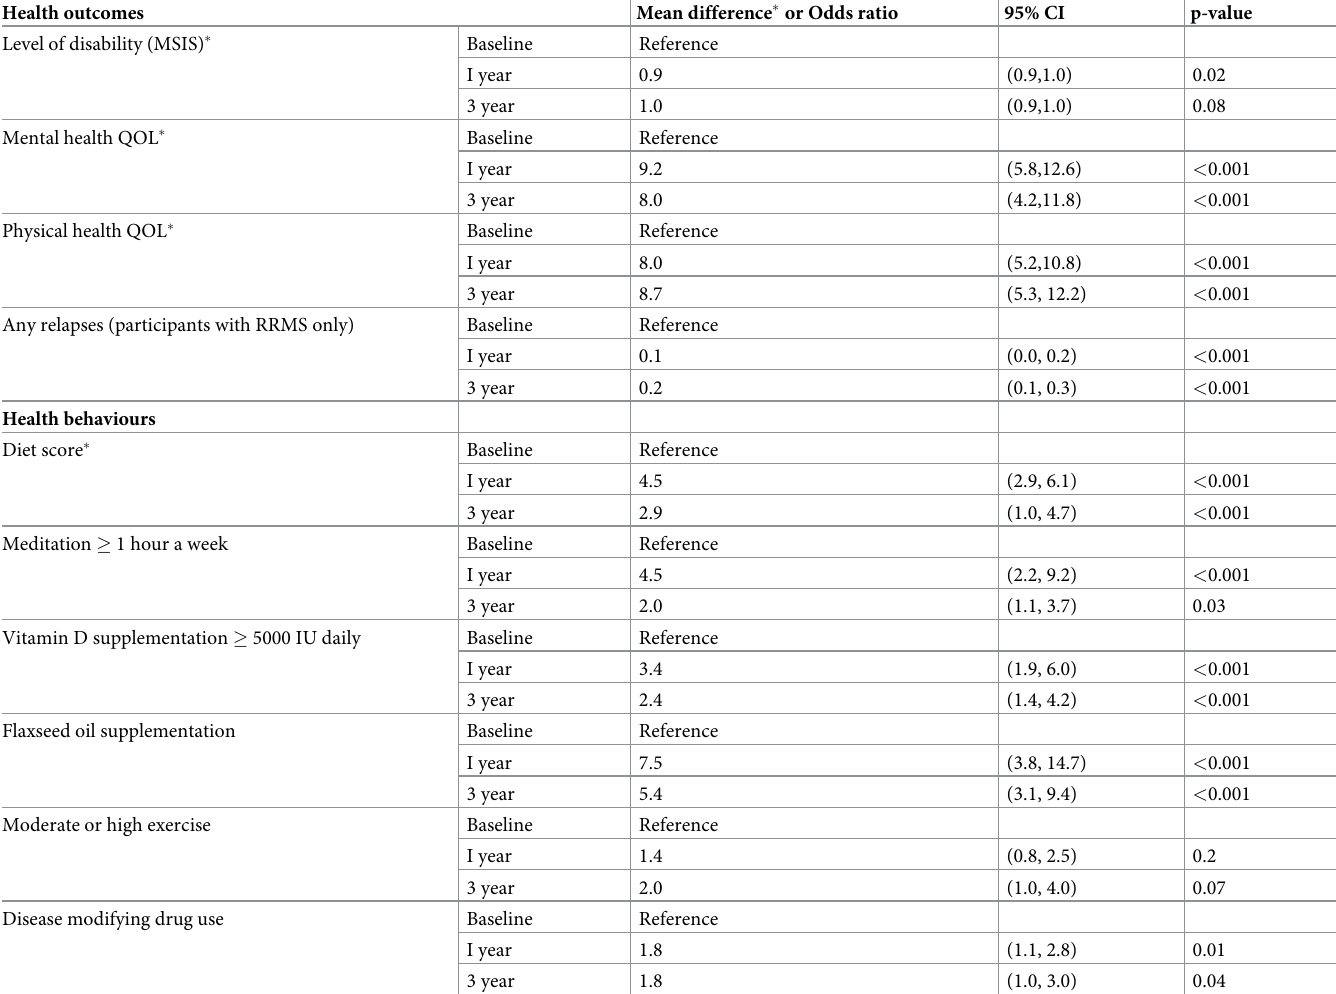
Table 3. Changes in health outcomes and health behaviours over time using generalized estimating equation models to account for within-participant correlation over